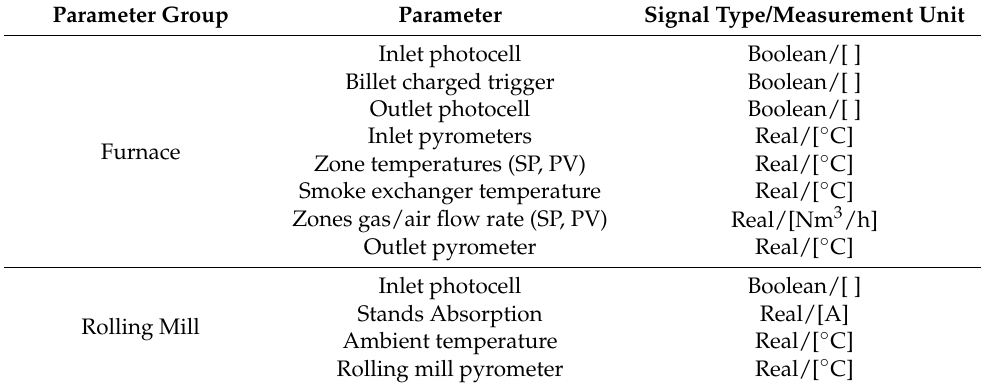
Table 5. Furnace/rolling mill